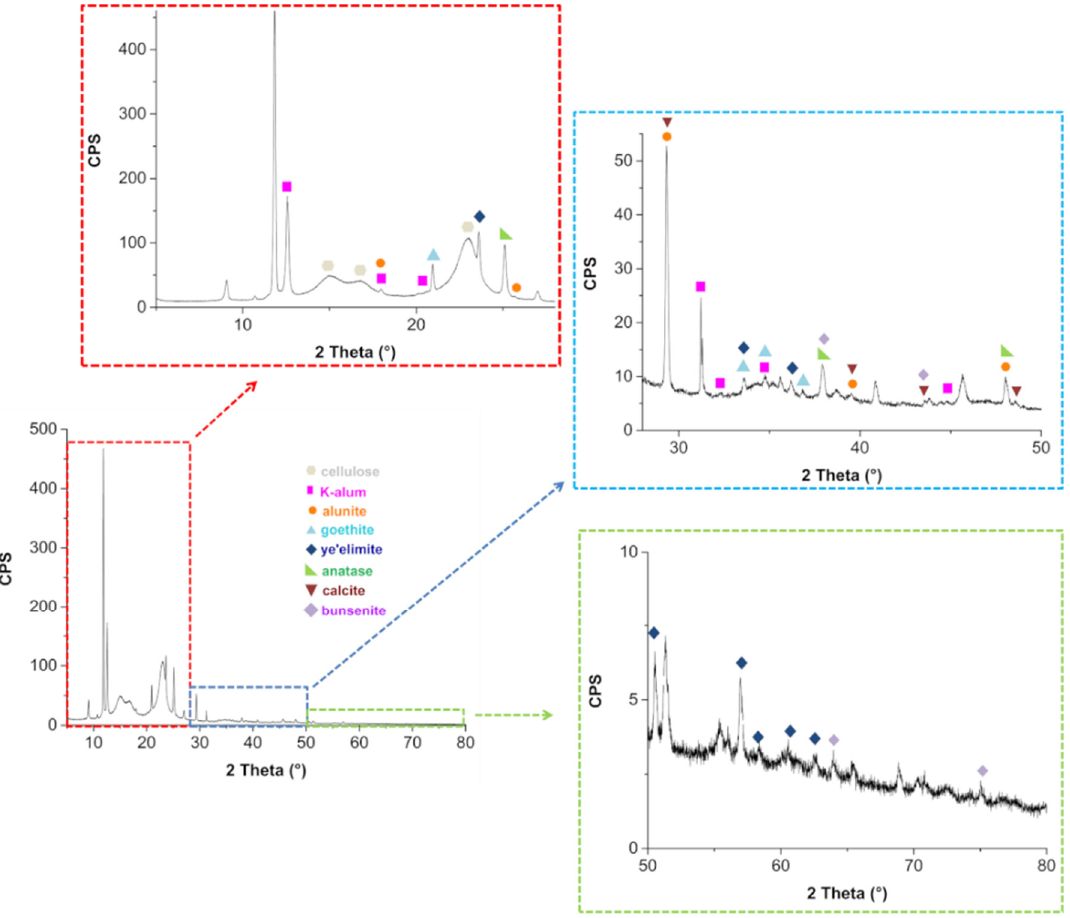
Figure 6. Untreated paper PXRD and related magnifications in the angular ranges 5–28° (red inset), 28–50° (blue inset) and 50–80° (green inset).